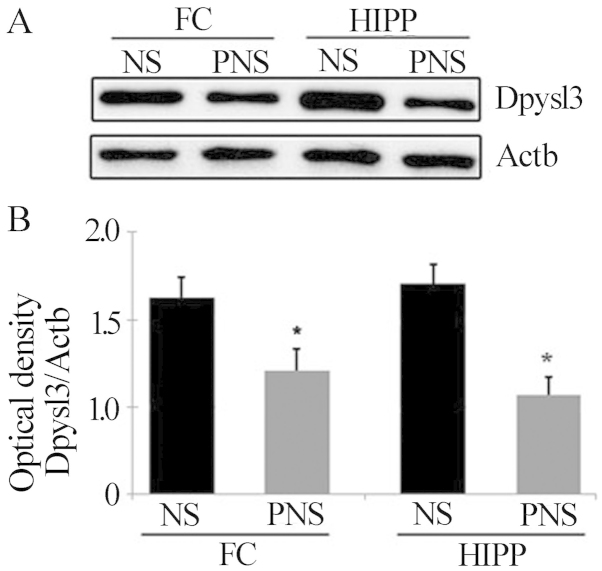
Western blot analysis of Dpysl3 expression in the brains of PNS-induced rats. (A) Dpysl3 expression was detected by western blotting with Actb used as an internal control. PNS rats exhibited decreased Dpysl3 expression in the prefrontal cortex and hippocampus. (B) Quantitative analysis of western blot data for Dpysl3 expression showing a significant difference in Dpysl3 levels in PNS vs. control rat brains (*P<0.05 compared with the NS group in the prefrontal cortex and hippocampus). Dpysl3, dihydropyrimidinase-like 3; FC, prefrontal cortex; Hipp, hippocampus; NS, non-prenatal stressed offspring; PNS, prenatal stressed offspring; SD, standard deviation.